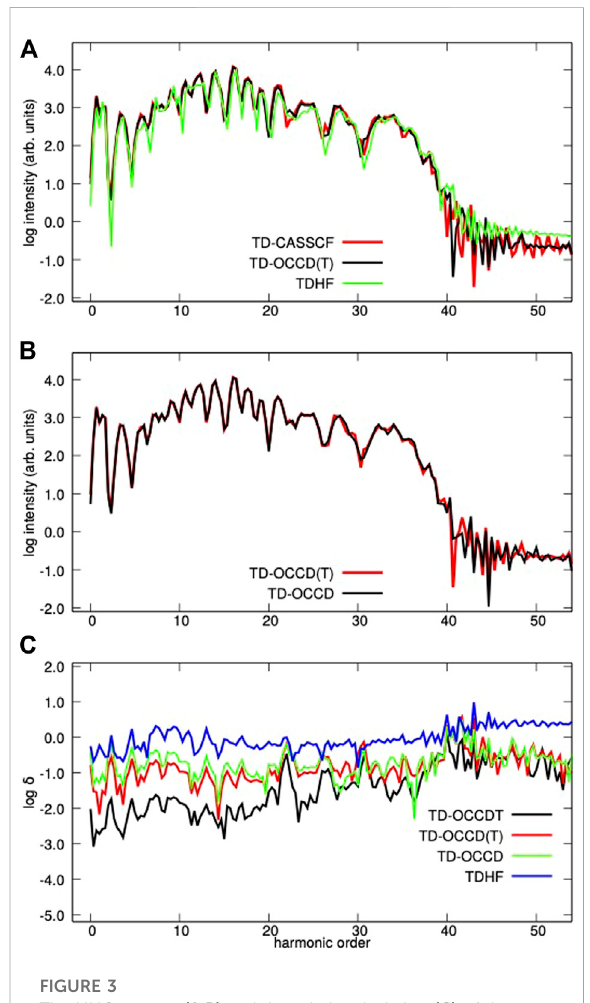
FIGURE 3 The HHG spectra (A,B) and the relative deviation (C) of the spectral amplitude from the TD-CASSCF spectrum from Kr irradiated by a laser pulse with a wavelengthof 800 nm and a peak intensity of 2 × 10 14 W/cm 2 with various methods.